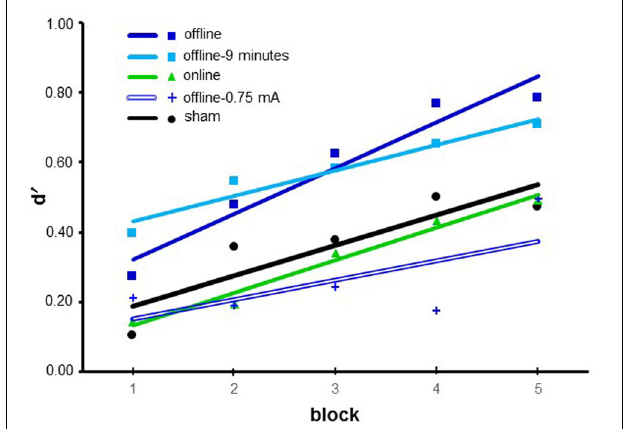
FIGURE 4 | Results of Experiment 2. Data are presented as the mean d (cid:4) values. The lines represent the fit of each condition. The blue line represents the offline 1.5mA for the 22min condition, the green line represents the online 1.5mA for the 22min condition, the turquoise line represents offline 1.5mA for the 9min condition, and the double blue line represents the offline-0.75mA for the 22min condition. The sham condition is shown in